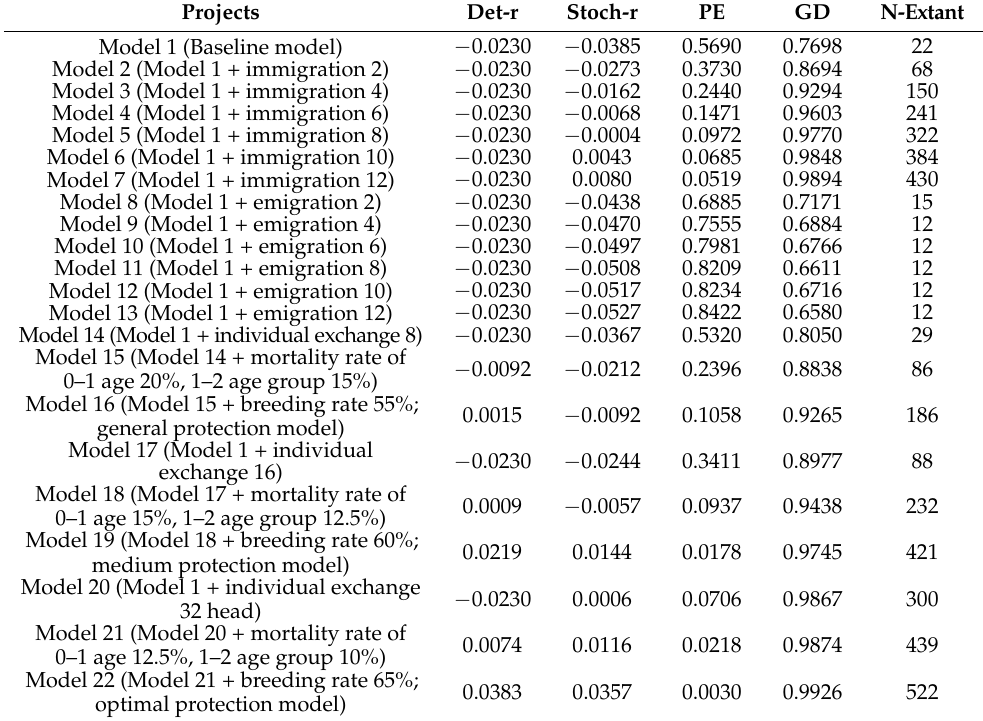
MBP: males in breeding pool; CS: catastrophes severity. A Max-Min plot shown the range of results for each tested variable, averaged across the values of all other tested variables. A point was placed at the result for the base scenario. In a Max-Min plot, the variables with the longest lines had the greatest effect on results). Table 2. The deterministic growth rate (Det-r), stochastic growth rate (Stoch-r), probability of extinction (PE), the genetic diversity (GD) and the population size (N-extant) in 100 years under different